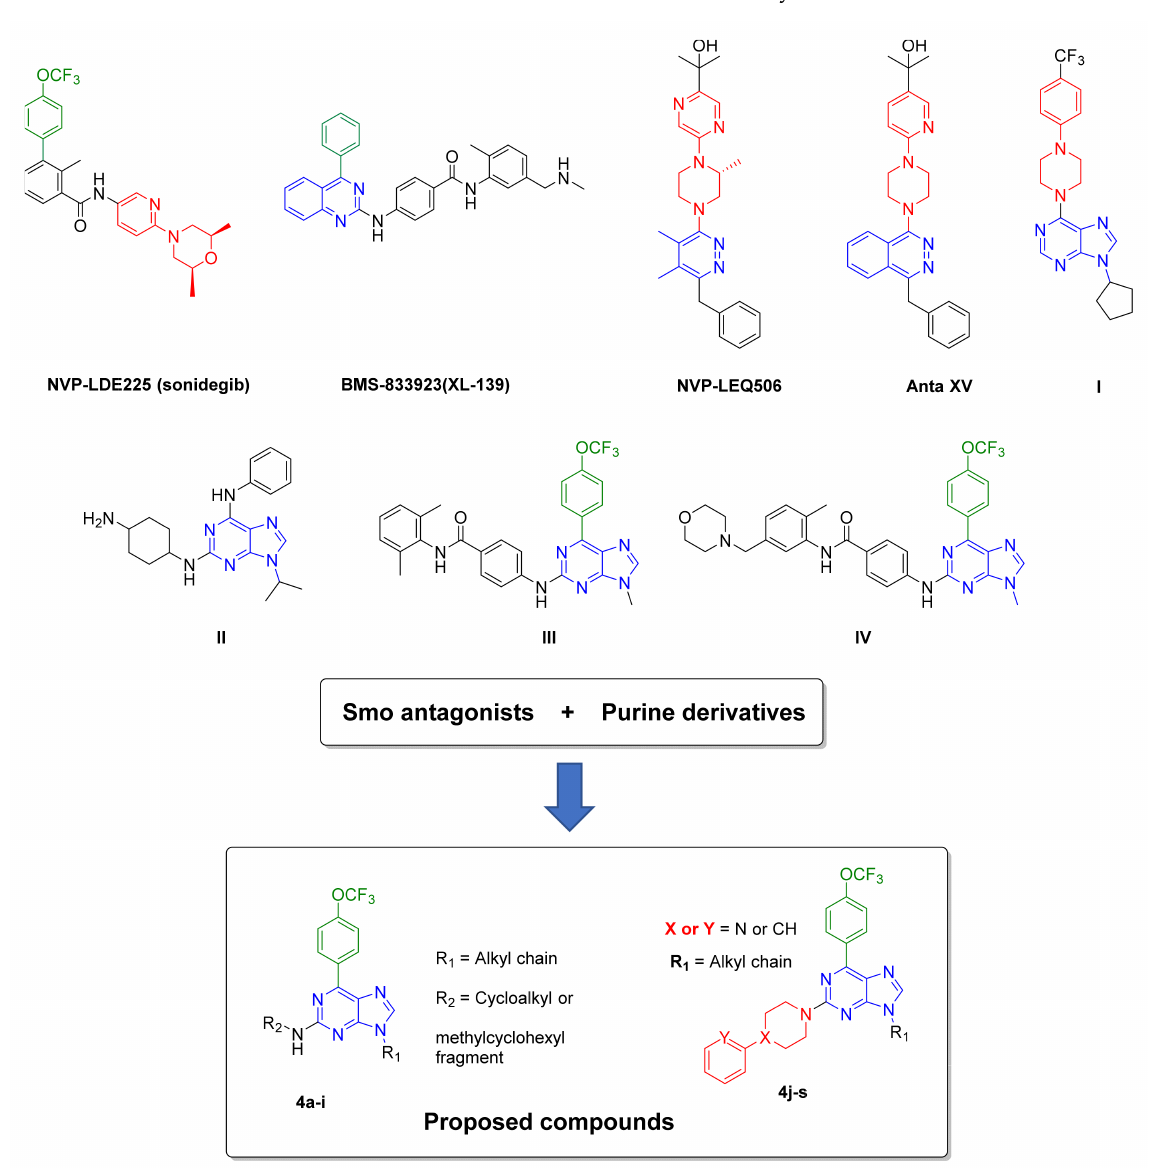
Figure 2. Chemical structures of SMO antagonists, biologically active purine derivatives with potential as anticancer agents, and purine derivatives designed to serve as SMO antagonists. In colour are shown the fragments considered in the design of these purine derivatives: in blue a heterocyclic core, in red an aryl-piperazine portion and in green the trifluoromethoxy